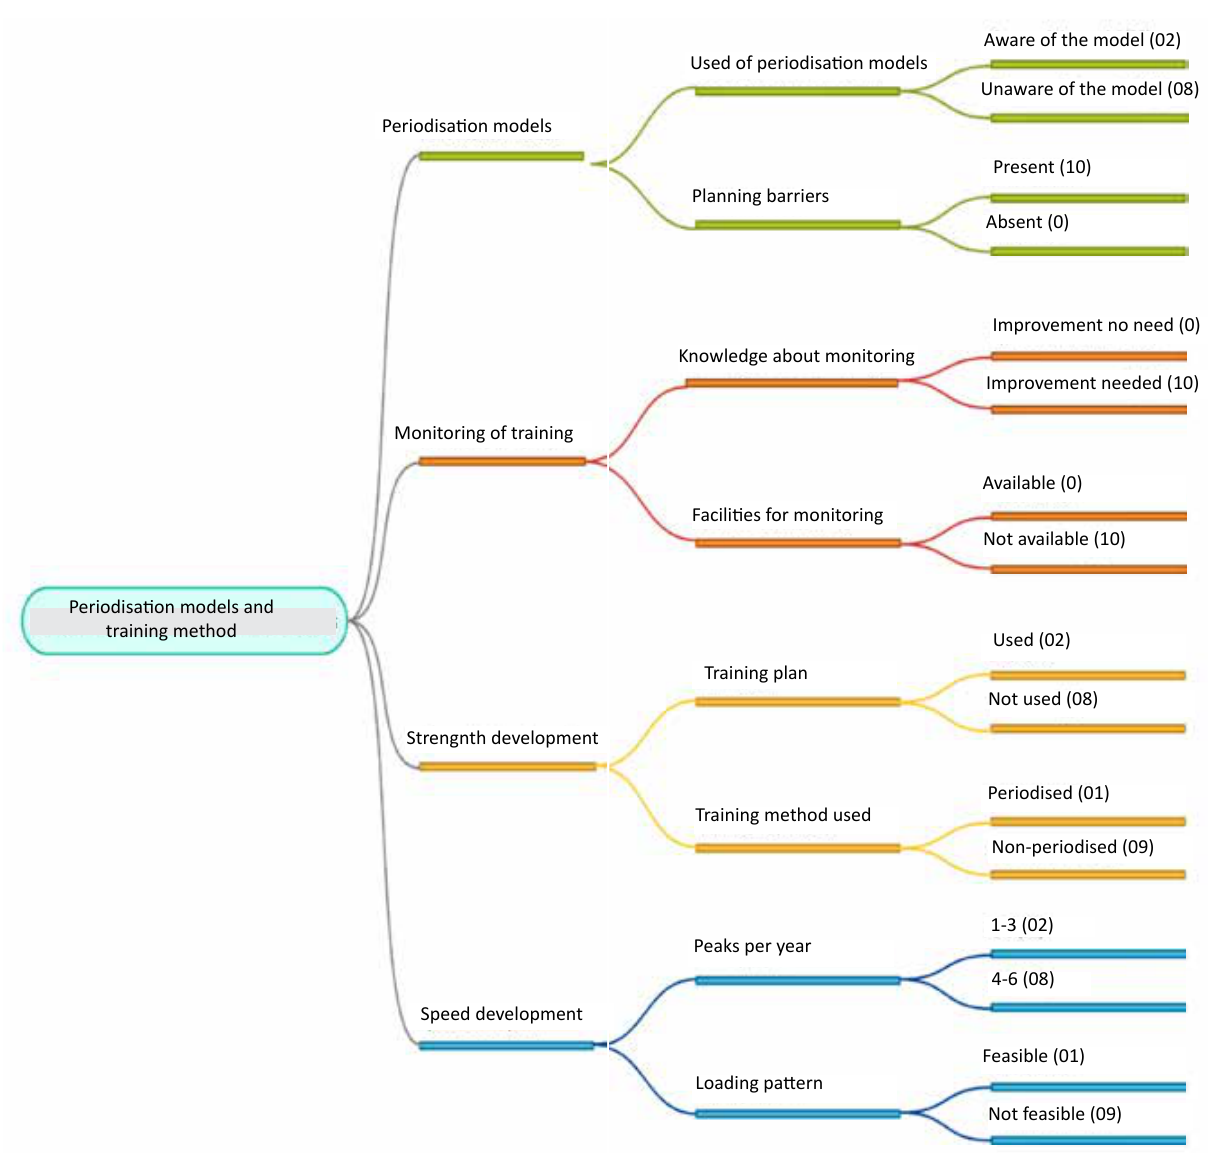
Figure 1. Thematic mind map of semi-structured